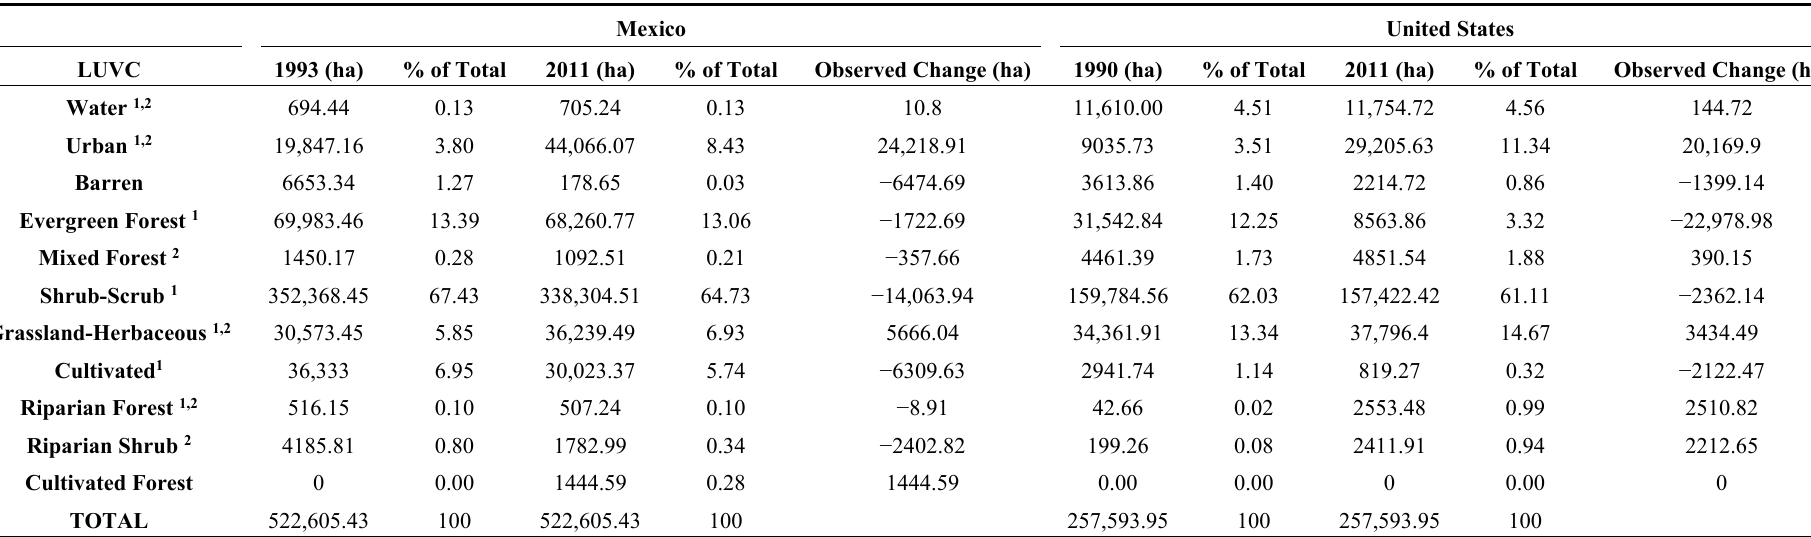
Table 3. Initial surface and change for each LUVC category, year, and country. Superscript number in LUVC category indicates more that 80% of area persistence, 1 for Mexico and 2 for United States.